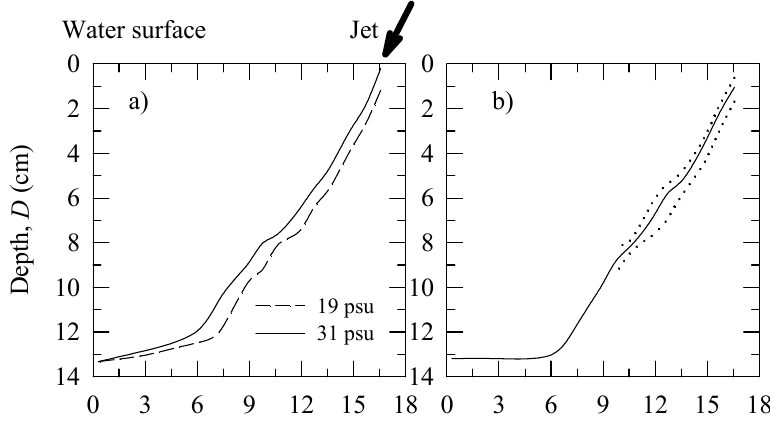
Figure 6. Bubble cloud shape: ( a ) Bubble cloud contours for salinity of 19 and 31 psu; ( b ) Bubble cloud contour only for fresh water (solid line) together with the ± standard deviation (dotted lines).